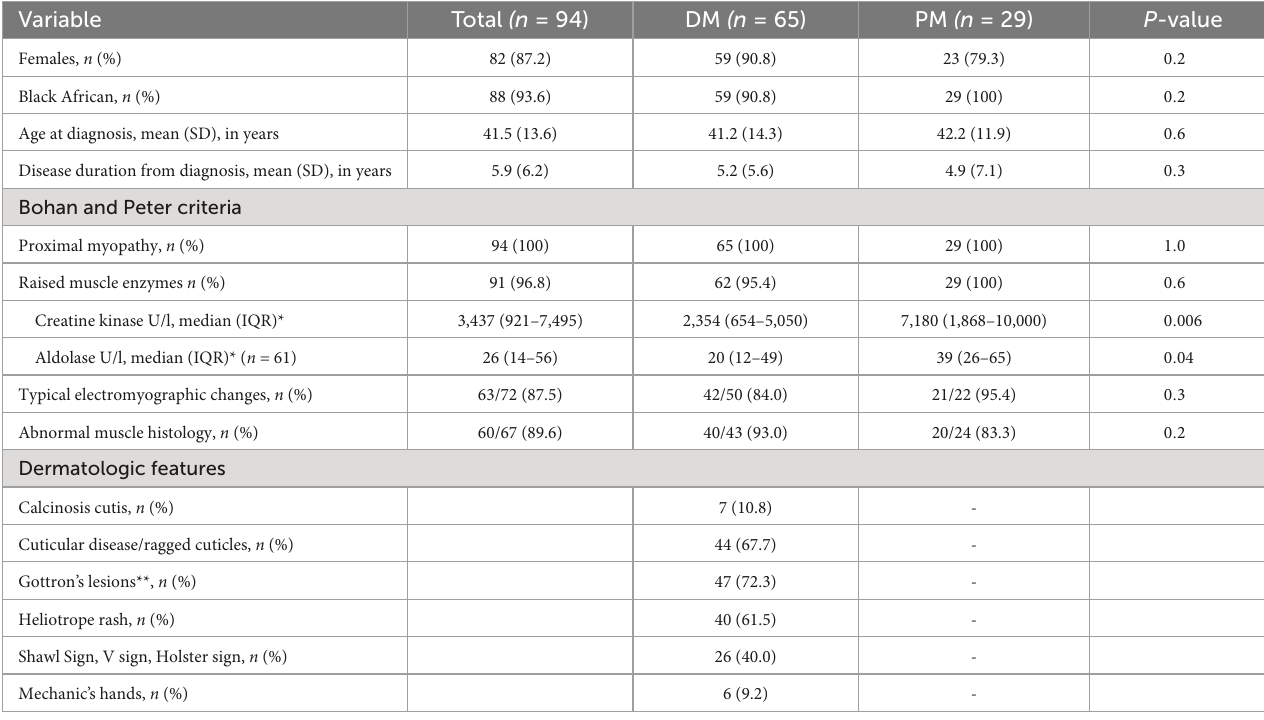
TABLE 1 Demographic and clinical characteristics of 94 patients with idiopathic inflammatory myopathy.